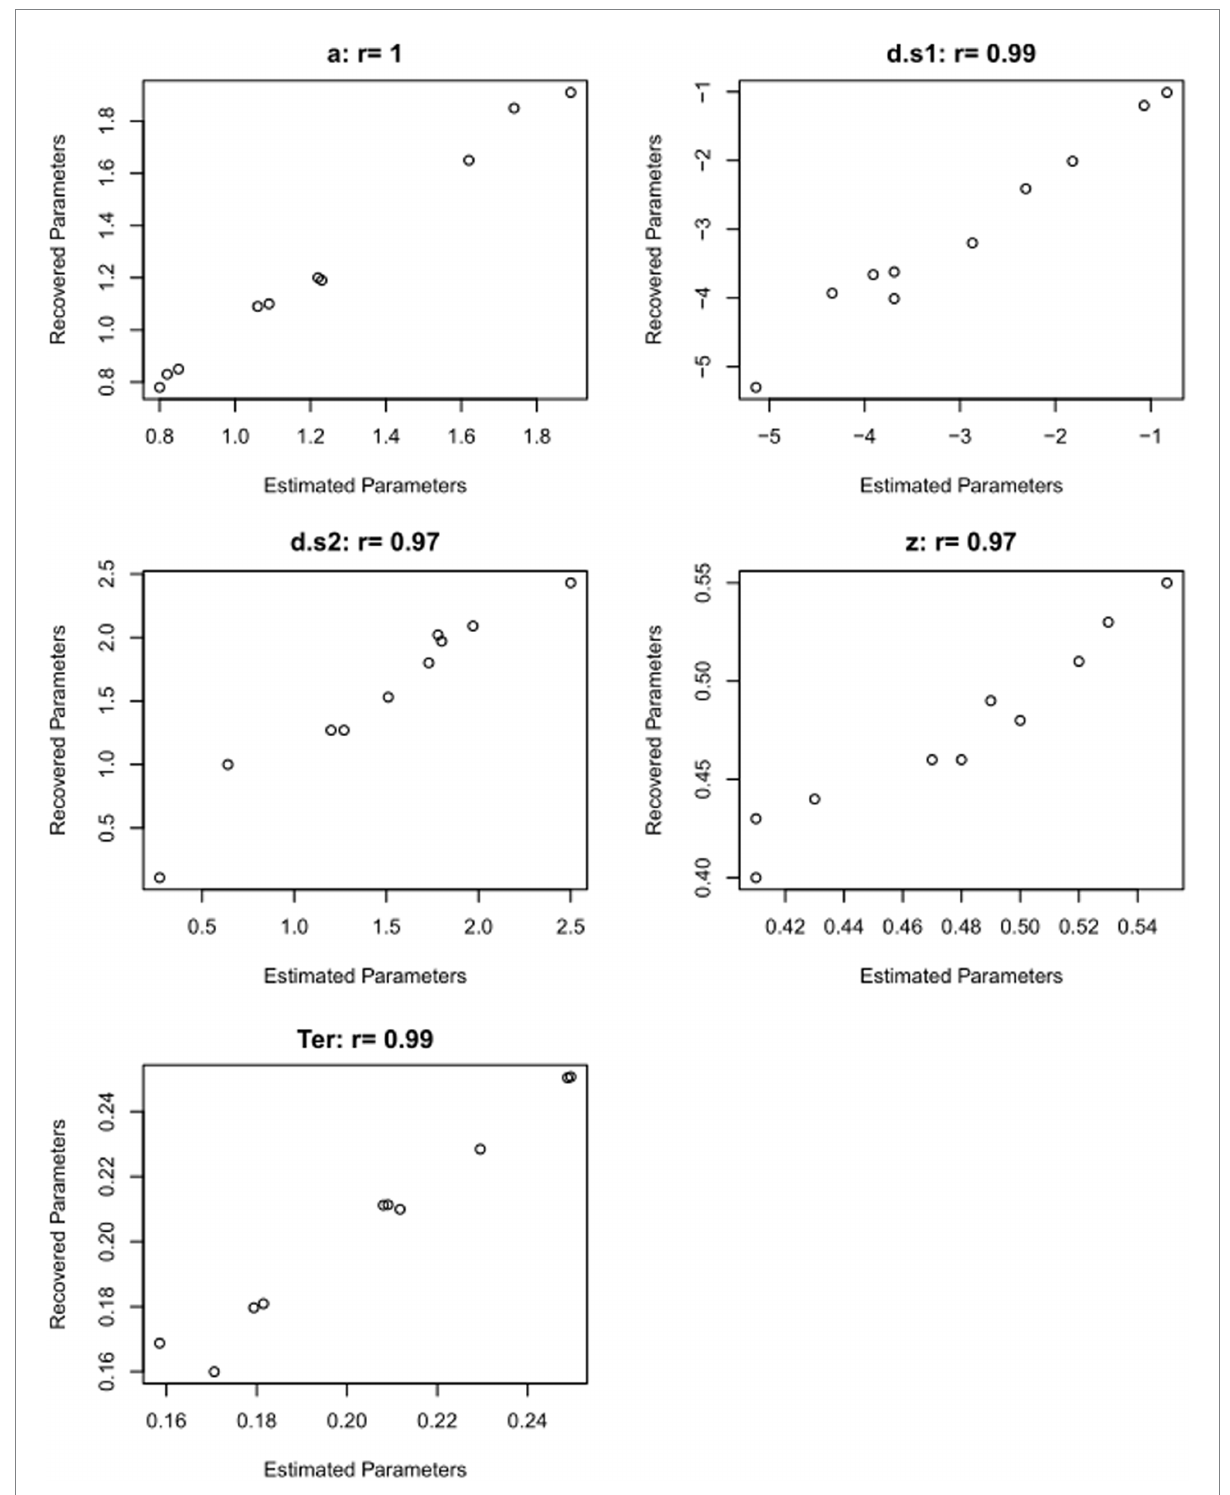
FIGURE 9 Validating the model: results from parameter recovery study. Scatterplots showing correspondence between estimated parameters (Table 4) and recovered parameters (Table 5), for the 10 simulated data files. Correlations of estimated and recovered values are excellent (Pearson’s r > 0.9 for all parameters). This increases our confidence that the DDM can accurately recover parameter values for this type of